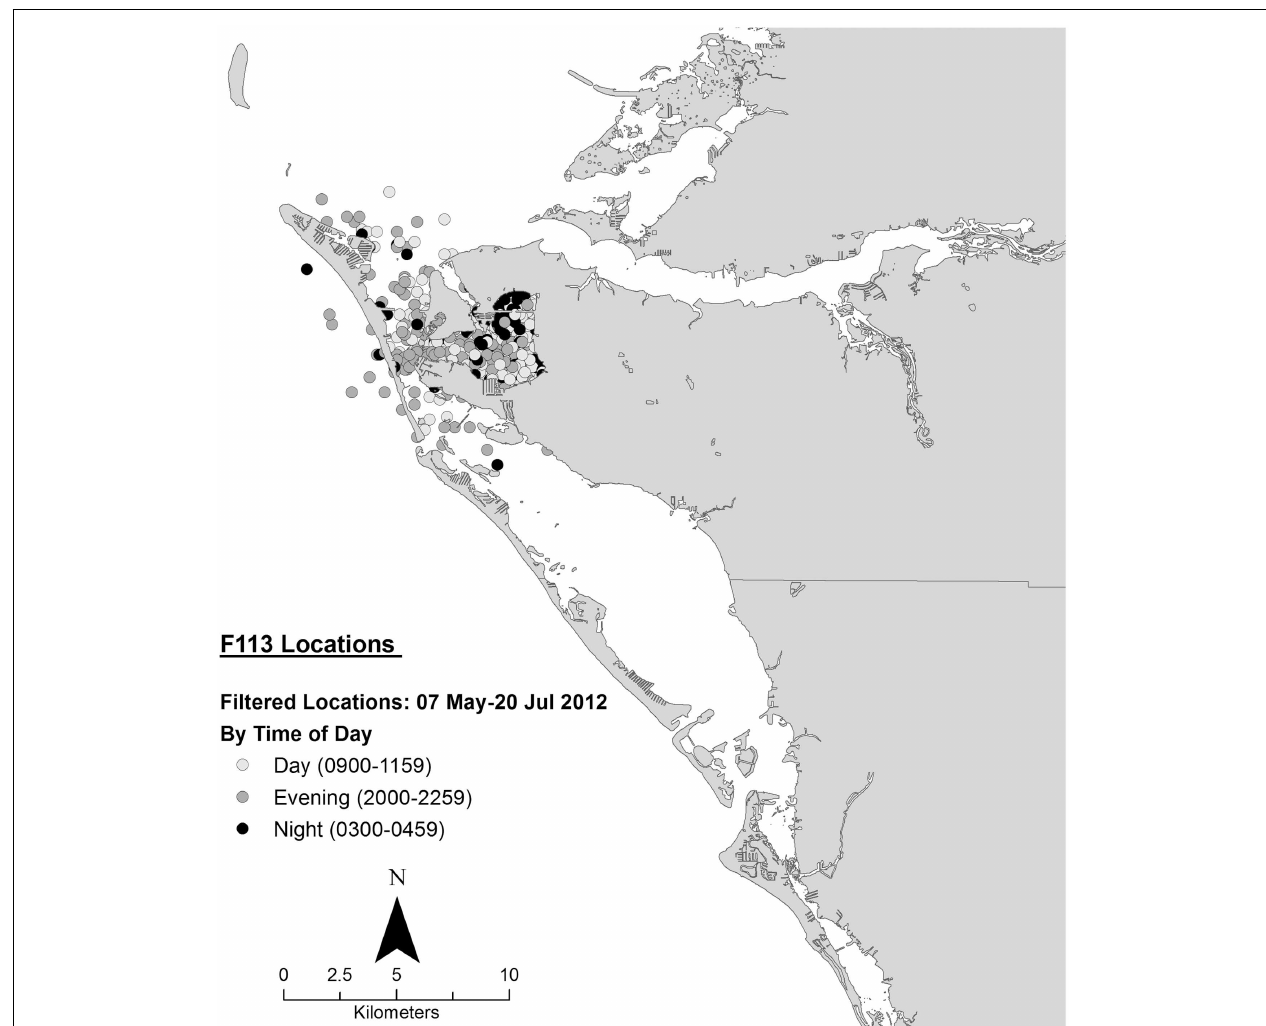
FIGURE 8 | Locations of bottlenose dolphin F113 relative to time of day during May–July 2012, from satellite-linked transmitter